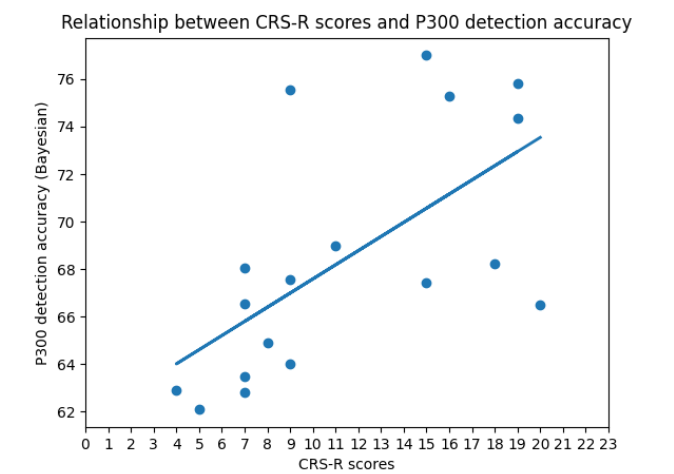
Figure 7. The graph shows the relationship (the linear correlation coefficient is 0.63165) between the CRS-R score and the accuracy of P300 detection ( Bayesian ) at a three-month follow-up. The horizontal axis is the patient’s CRS-R score, and the vertical axis is the corresponding P300 detection accuracy ( Bayesian